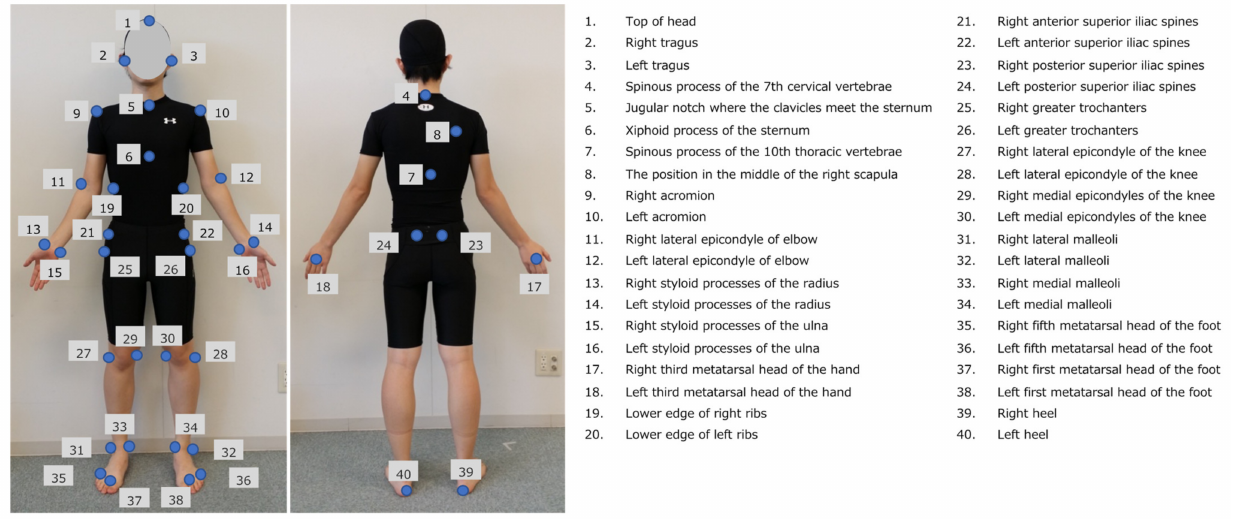
Figure 2. Marker locations for motion